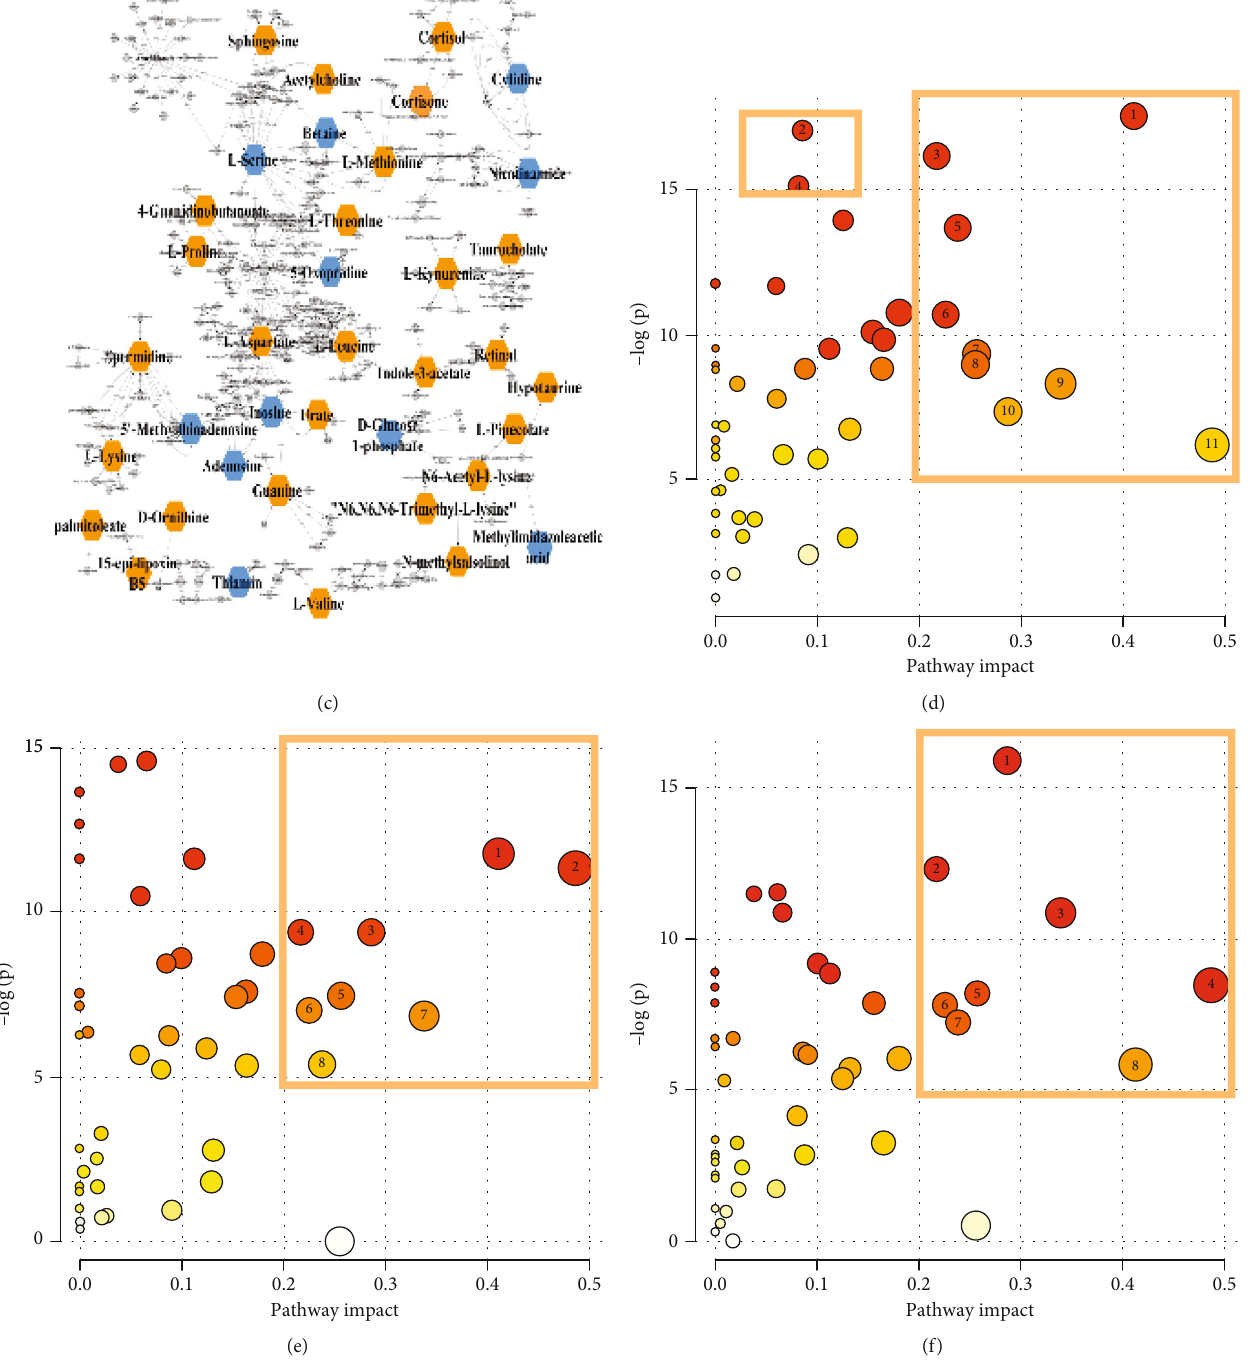
Figure 5: Metabolism network analysis of three treatment groups: (a) DSS group vs control group. (b) CA group vs control group. (c) GA group vs control group. Blue indicates downregulated metabolites, and red indicates upregulated metabolites. Metabolism pathway analysis of the four groups. The x -axis and the y -axis represent the pathway impact and enrichment, respectively. The critical pathways are framed by yellow boxes. (d) DSS vs control, 1-taurine and hypotaurine metabolism; 2-steroid hormone biosynthesis;